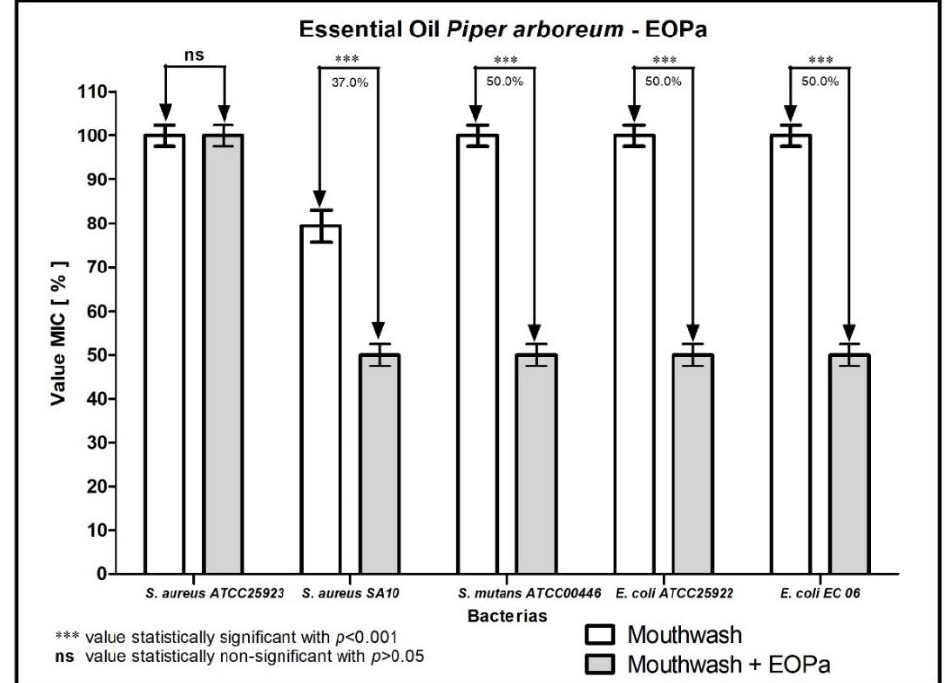
Figure 2 Evaluation of the modulating activity of EOPa combined with mouthwash against Figure 2. Evaluation of the modulating activity of EOPa combined with mouthwash against bacte- bacterial strains. rial strains.